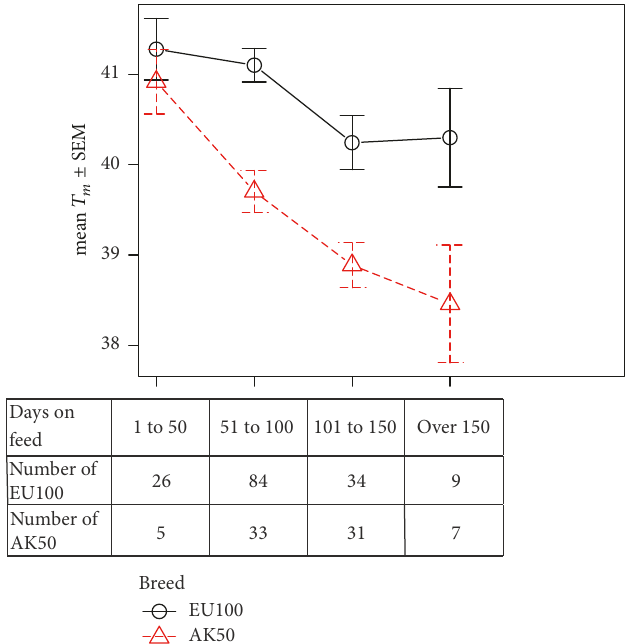
Figure 3: Red Wagyu sired carcasses have lower 𝑇 𝑚 for equivalent DOF. 𝑇 𝑚 was measured for subcutaneous fat samples taken from the loins of 229 carcasses. The cattle were backgrounded on pasture and then fed on pellets until they reached a satisfactory weight and fatness. The results are grouped by days on feed and by breed of sire (European or Akaushi). The dams of all carcasses were European breeds. Breed and days on feed were both statistically significant influences on 𝑇 𝑚 , with 𝑝 < 0.01 calculated by multiway ANOVA. The difference between the two groups was significant after only 51–100 days on feed.